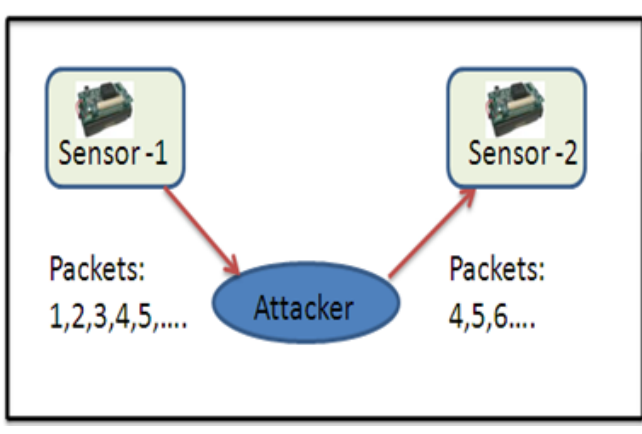
Figure 9. Selective Forwarding